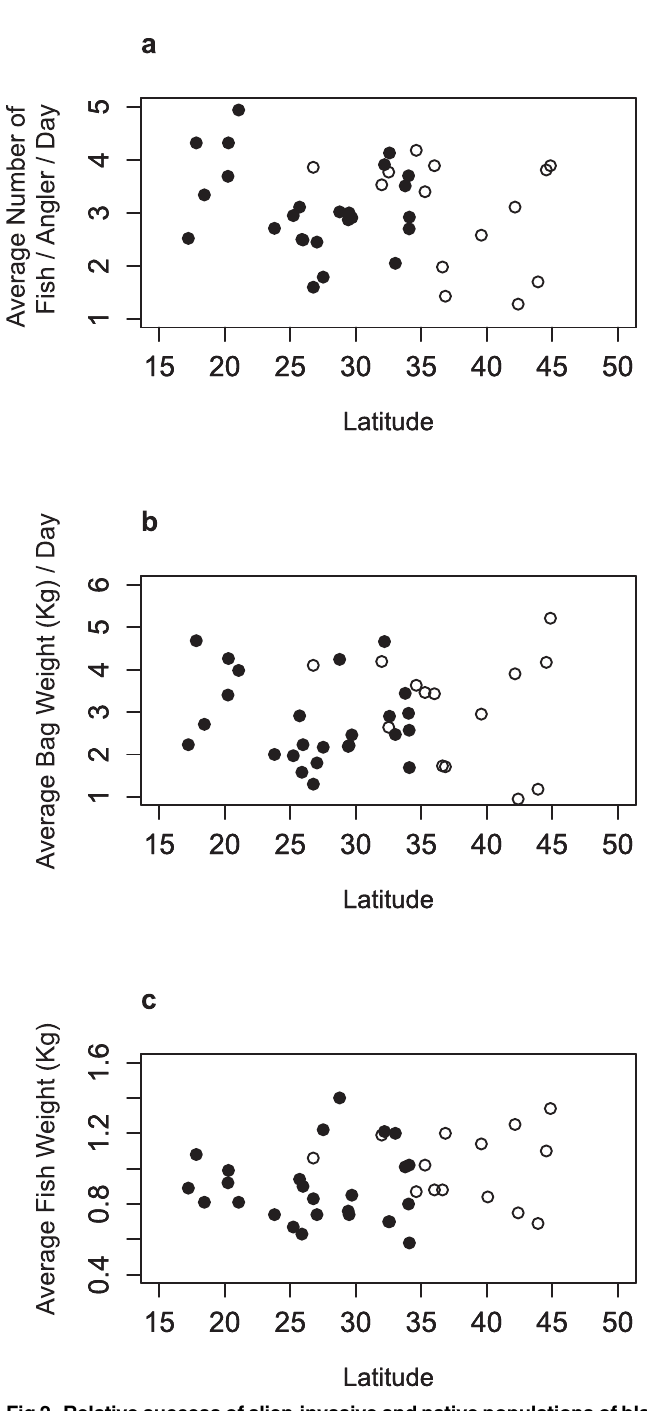
PLOS ONE | DOI:10.1371/journal.pone.0130056 June 5,